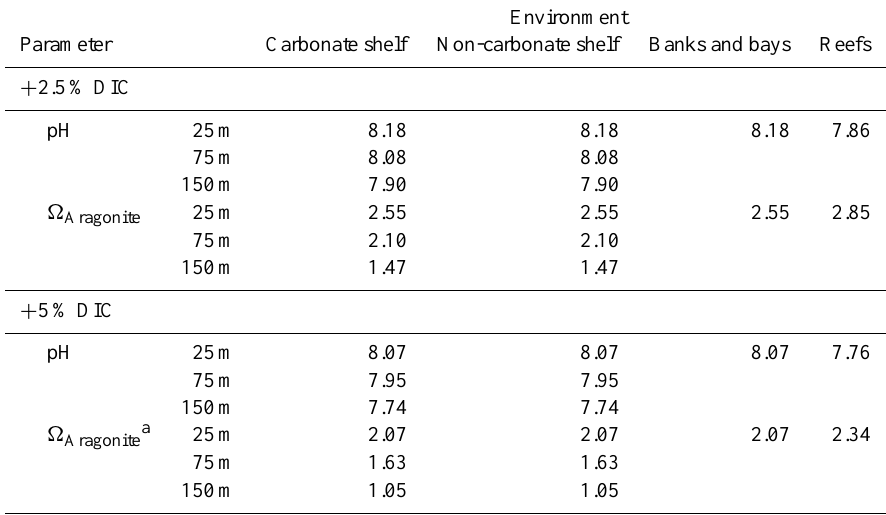
Table 6b. Boundary pH and (cid:127) Aragonite for DIC sensitivity